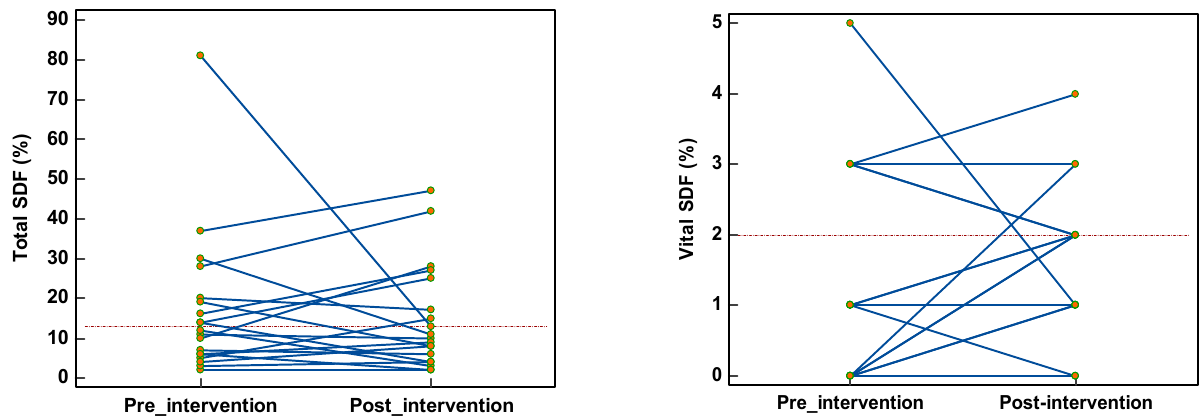
Figure 7. Effect of nutrient supplementation on total and vital SDF.